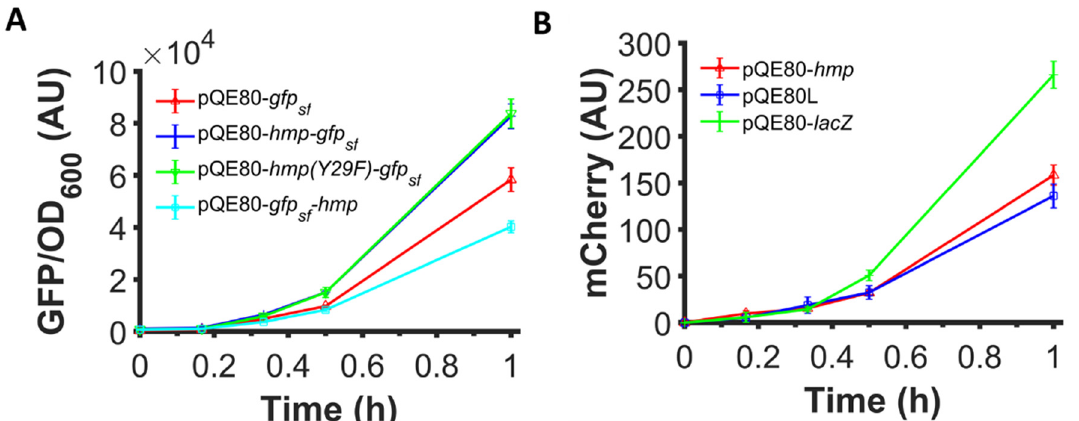
Figure 6. N-terminal fusion is required and O 2 binding and ·NO detoxification activities are dispensable for Hmp to boost protein expression. Shown are ( A ) GFP fluorescence normalized by OD 600 after subtraction of the background signal (wild- type harboring pQE80L) of wild-type E. coli harboring pQE80-P T5 - gfp sf (pXW09) , pQE80-P T5 - hmp-gfp sf (pXW08) , pQE80-P T5 - hmp(Y29F)-gfp sf (pXW14), whose O 2 -binding site is destroyed, and pQE80-P T5 - gfp sf -hmp (pXW15) induced by 1 mM IPTG at time 0. ( B ) mCherry fluorescence of MO001 ( lacIq , Δ lacZYA ::P T5 -mCherry ) harboring pQE80-P T5 - hmp (pXW20) , pQE80L (empty vector), and pQE80-P T5 - lacZ (pXW11) induced by 1 mM IPTG at time 0. Corresponding OD 600 measurements and data of uninduced samples can be found in Figure S5. Data are the means of at least three independent replicates, and error bars represent the standard errors of the means.